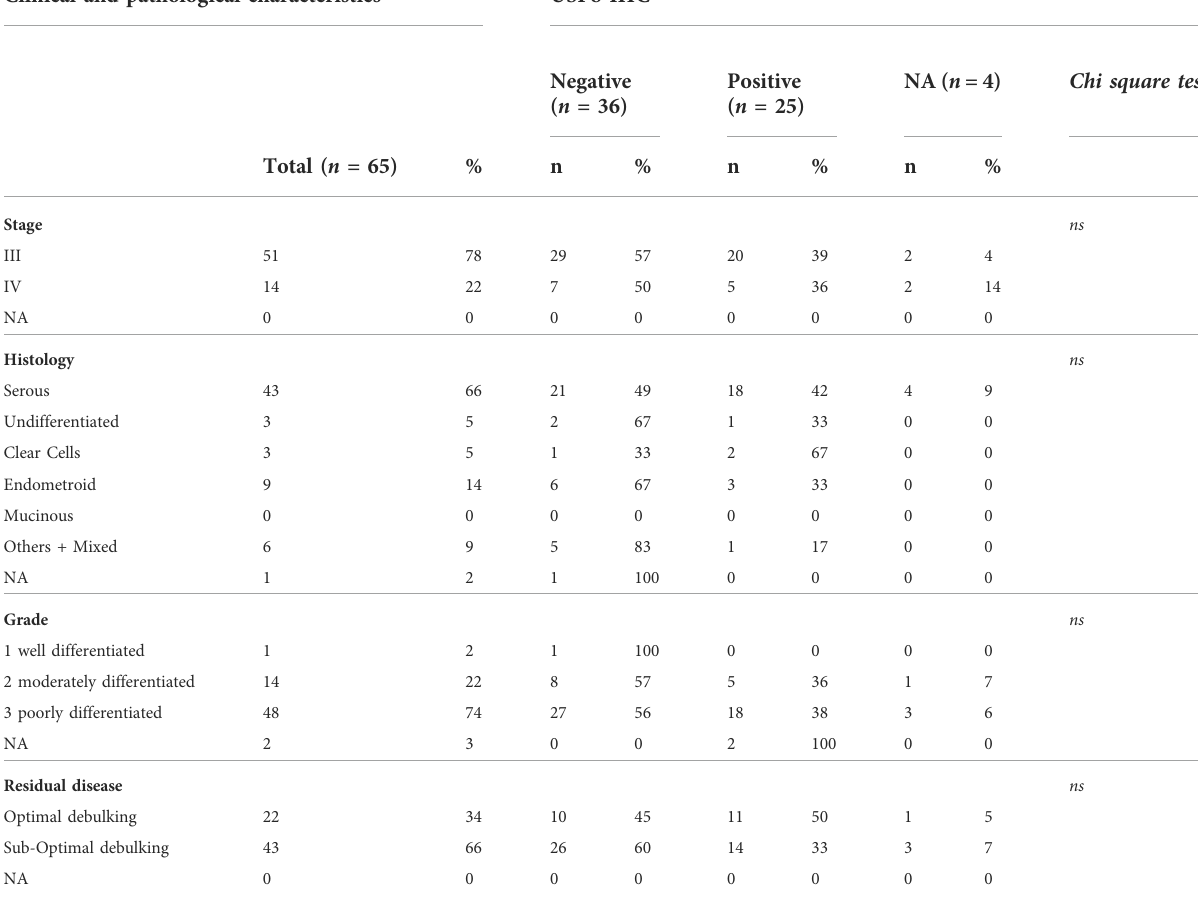
TABLE 1 Classi fi cation of patients based on clinical and pathological characteristics and distribution of USP8 expression a . Clinical and pathological